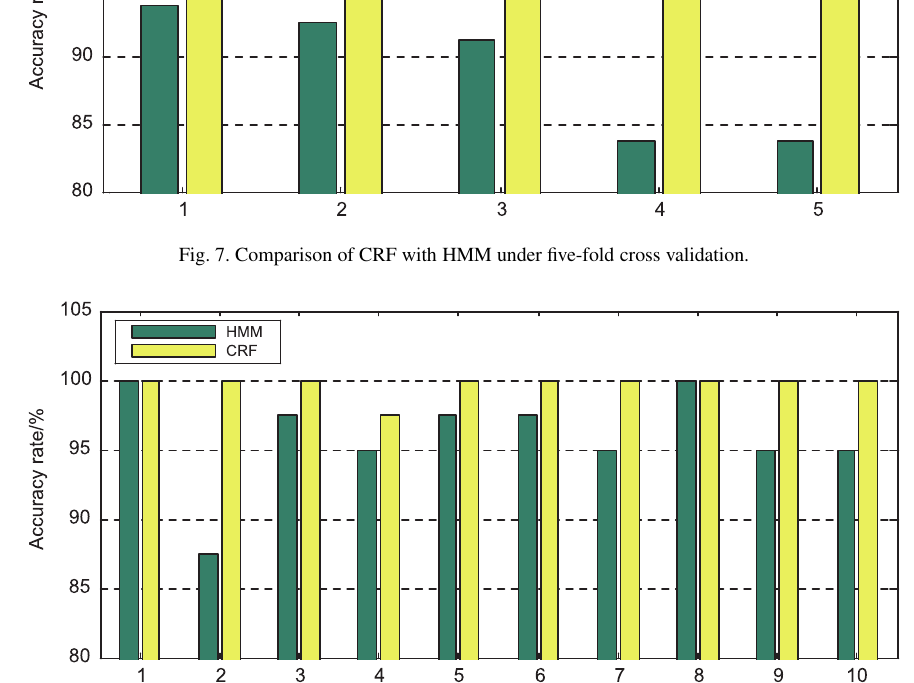
Fig. 8. Comparison of CRF with HMM under ten-fold cross